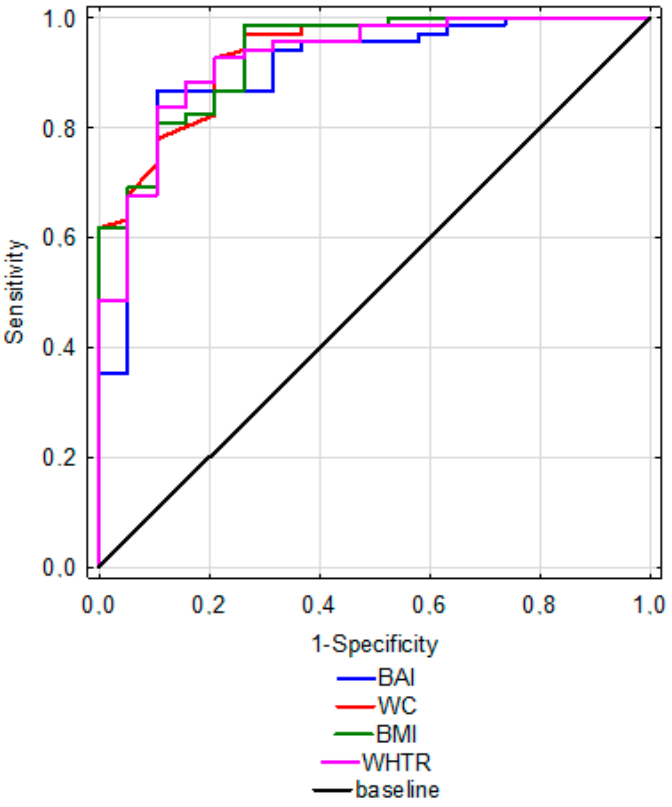
Figure 2. A summary of ROC curves for WC, BMI, BAI, and WHTR.